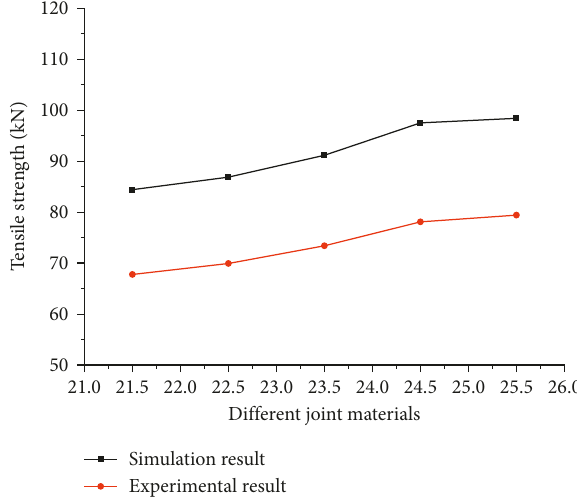
Figure 37: Tensile strength of joints with different center angles.